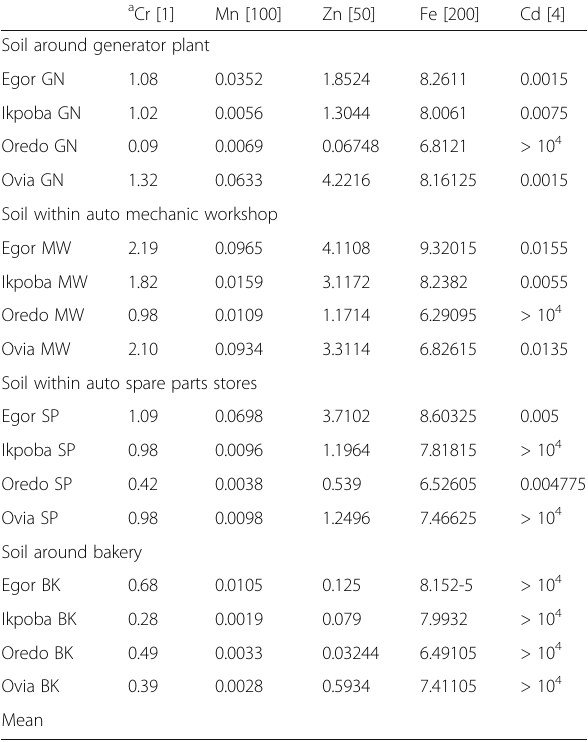
Table 1 Ecological hazard quotient of the heavy metal composition of spent crude oil-polluted soil within Benin